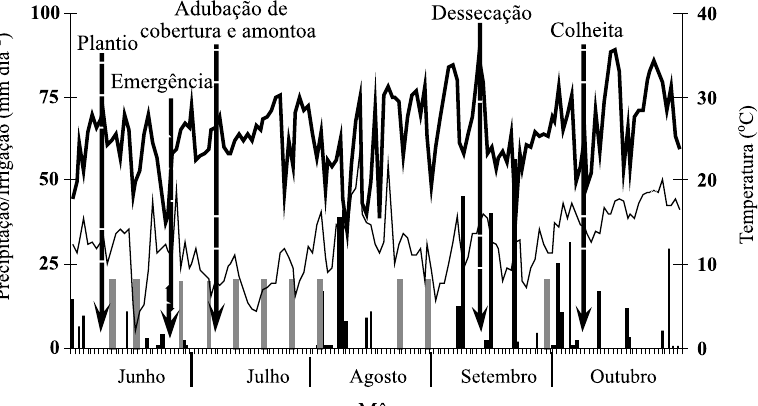
Figura 1. Precipitação pluvial ( ), irrigação ( ), temperaturas máximas ( ) e mínimas ( ) registradas na área do experimento, durante o período de junho a outubro de